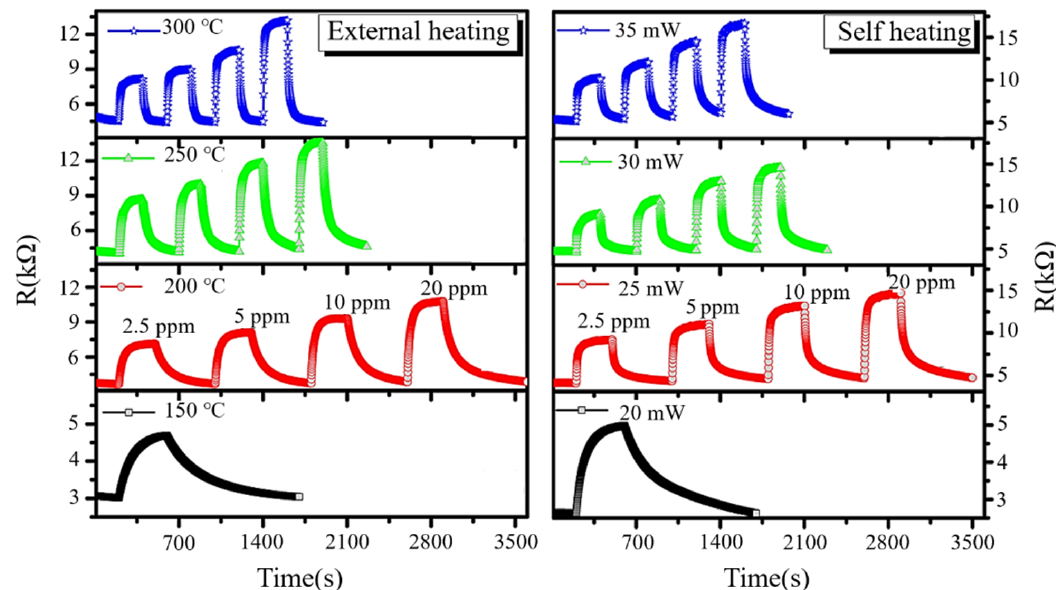
Figure 14. Performance of a sensor under external heating and self-heating effect. Adapted from [149] copyright (2017), with permission from American Chemical Society.